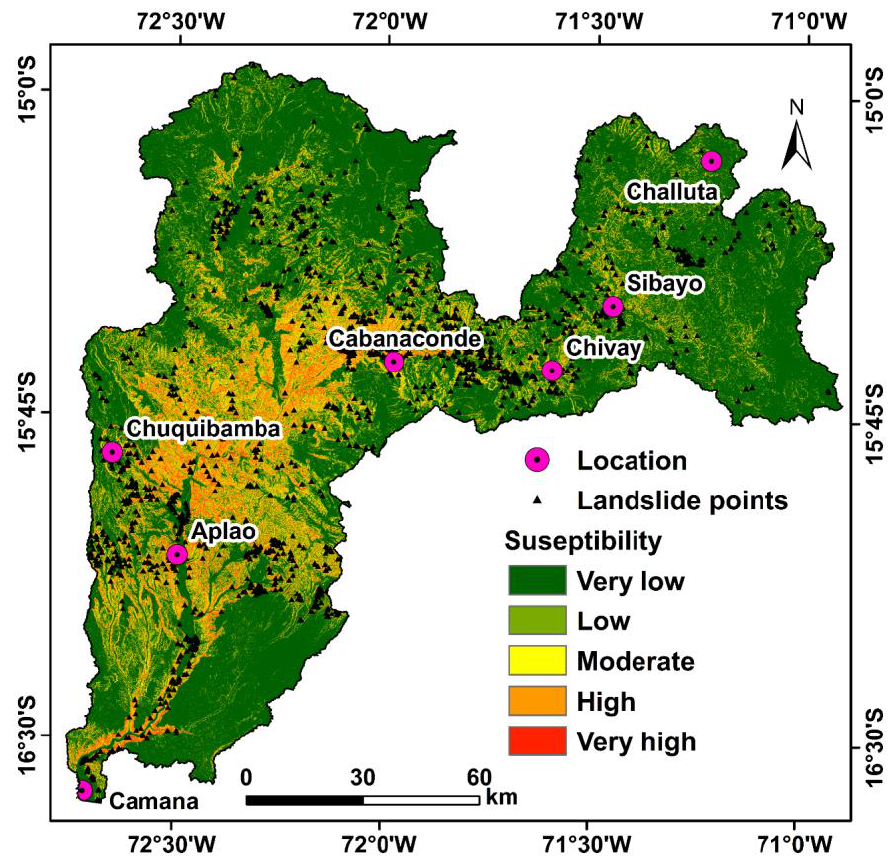
Figure 11. Landslide susceptibility map of the study area derived from the KNN + RTF using the top 5 LIFs.